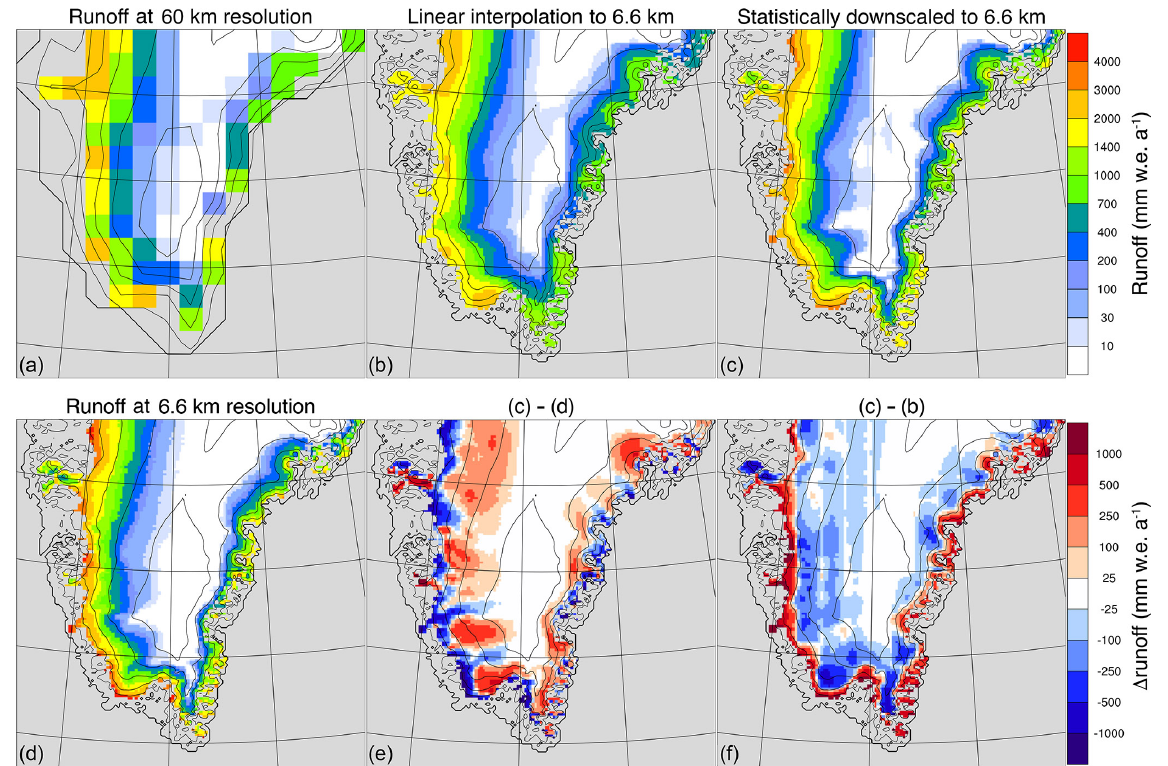
Figure 4. Results from refining runoff from 60km resolution to 6.6km resolution. (a) Modelled runoff at 60km resolution. (b) Bilinear inter- polated runoff. (c) Statistically downscaled runoff using local regression to elevation. (d) Modelled runoff at 6.6km resolution. (e) Difference between statistically downscaled (c) and modelled (d) runoff. (f) Difference between statistically downscaled (c) and bilinear interpolated (b) runoff.